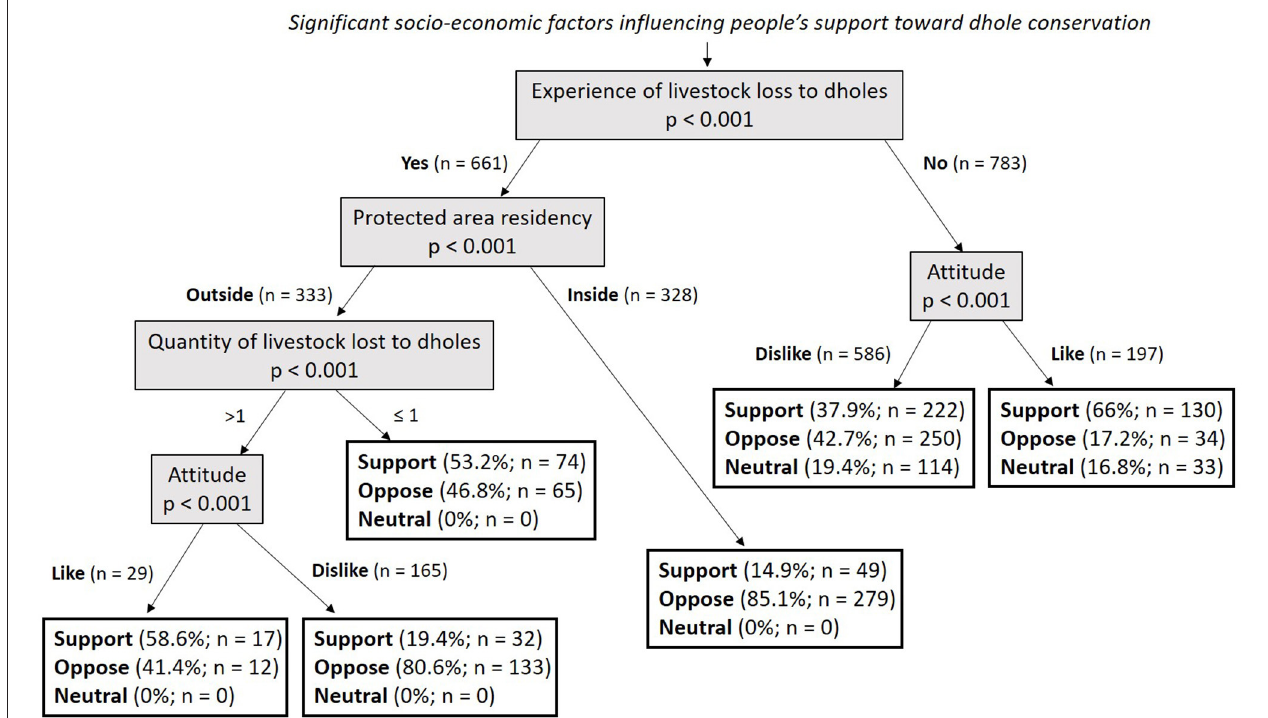
FIGURE 4 | Conditional inference tree showing “experience of livestock loss to dholes” as the primary significant predictor of local people’s support toward conserving the endangered dhole (Cuon alpinus) in Bhutan. Statistical significance of the tree splits is indicated by p -values.